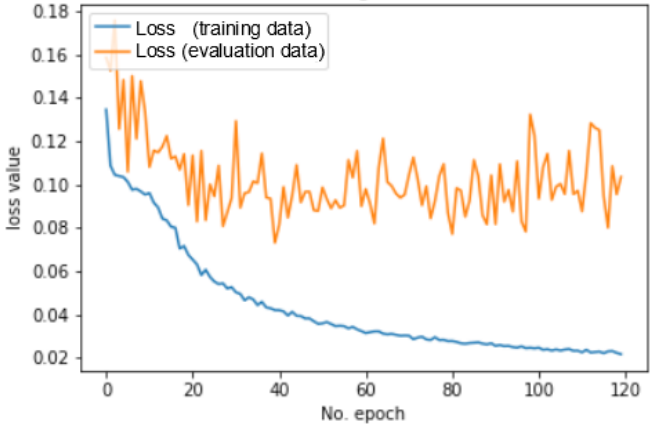
Figure 7. Evolution of loss value with increasing number of